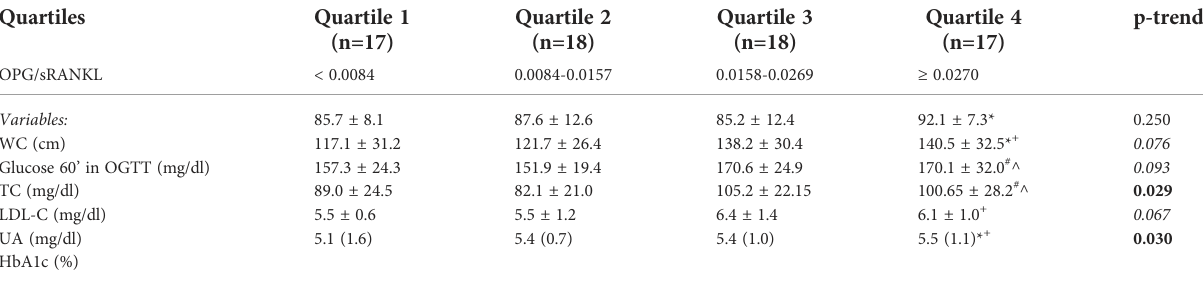
TABLE 3 Characteristics of chosen anthropometric and biochemical parameters after strati fi cation according to the OPG/sRANKL ratio quartiles in the study group. Quartiles Quartile 1